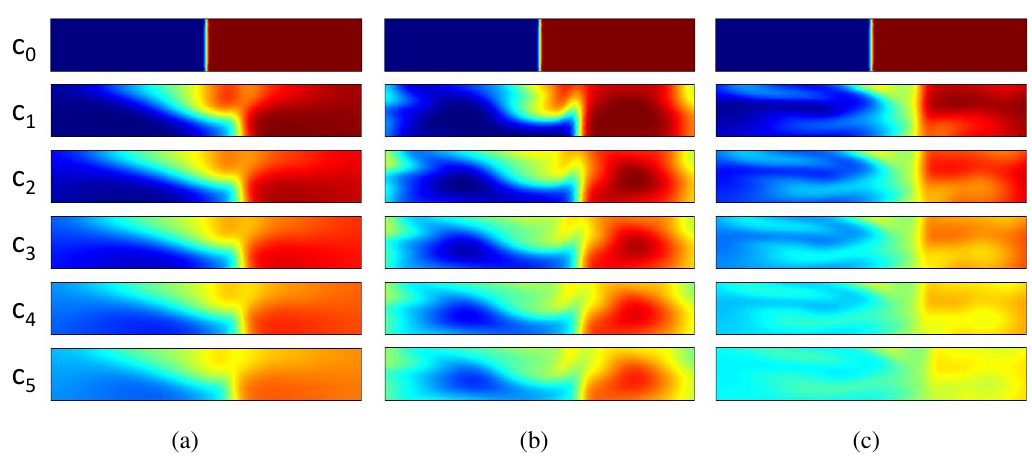
Figure 7. Evolution of the concentration in the mixer with α = 0 . 25 at the three Reynolds